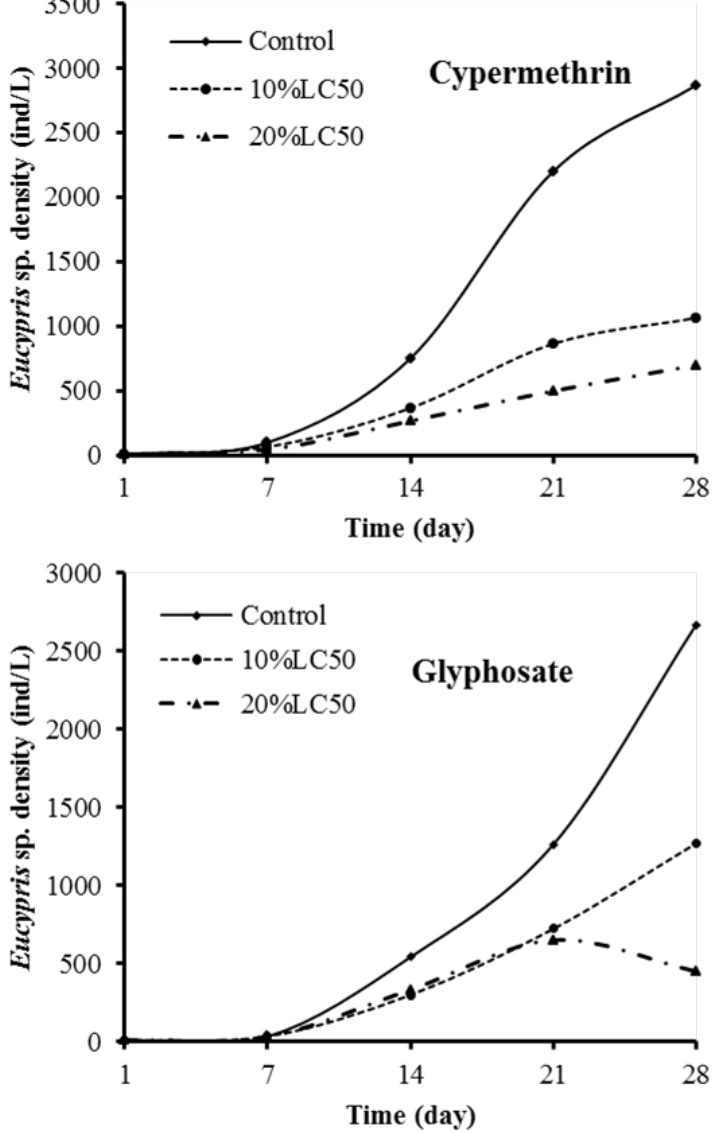
Figure 5. Temporal growth of Eucypris sp. density under low concentrations of cypermethrin and glyphosate conditions.